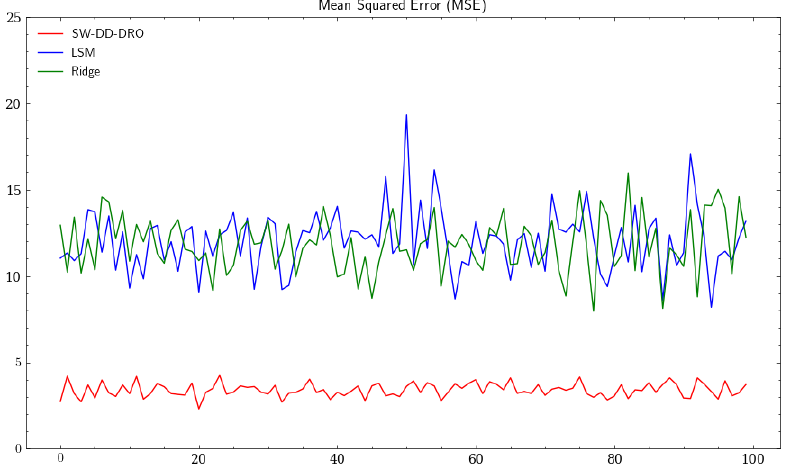
Figure 2. The red, blue, and green curves represent the MSE under the SW-DD-DRO, the least-squares methods, and the ridge regression,